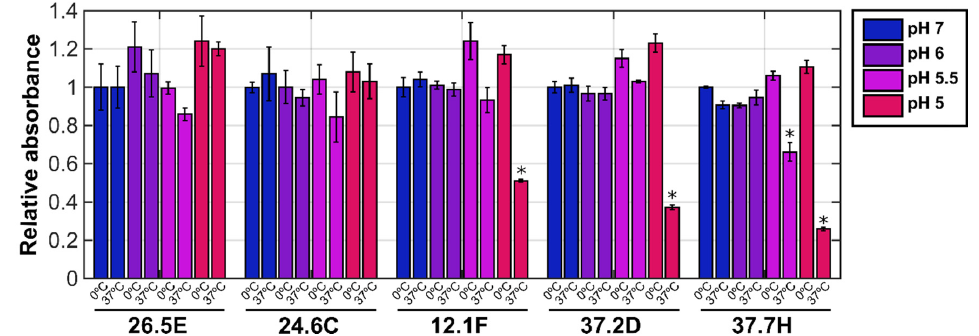
Figure 2. The binding of neutralizing and non-neutralizing antibodies to LASV GP after exposure to acidic pH at physiological temperature. VSV ∆ G-GFP-GP viral pseudotypes were treated with either phosphate buffer at pH 6.0 or 7.0, or acetate buffer at pH 5.5 or 5.0 at the indicated temperature for 30 min. Virus was subsequently brought back to neutral pH and assayed for binding by non-neutralizing (26.5E, 24.6C) and neutralizing antibodies (12.1F, 37.2D, 37.7H) by ELISA [32]. Data are presented as the mean of three biological replicates and error bars represent standard error of the mean. An asterisk indicates a statistically significant difference as compared to the case of incubation at 0 °C and pH 7 ( p < 0.05.) calculated using a one-way ANOVA. The lack of an asterisk indicates no statistically significant difference.